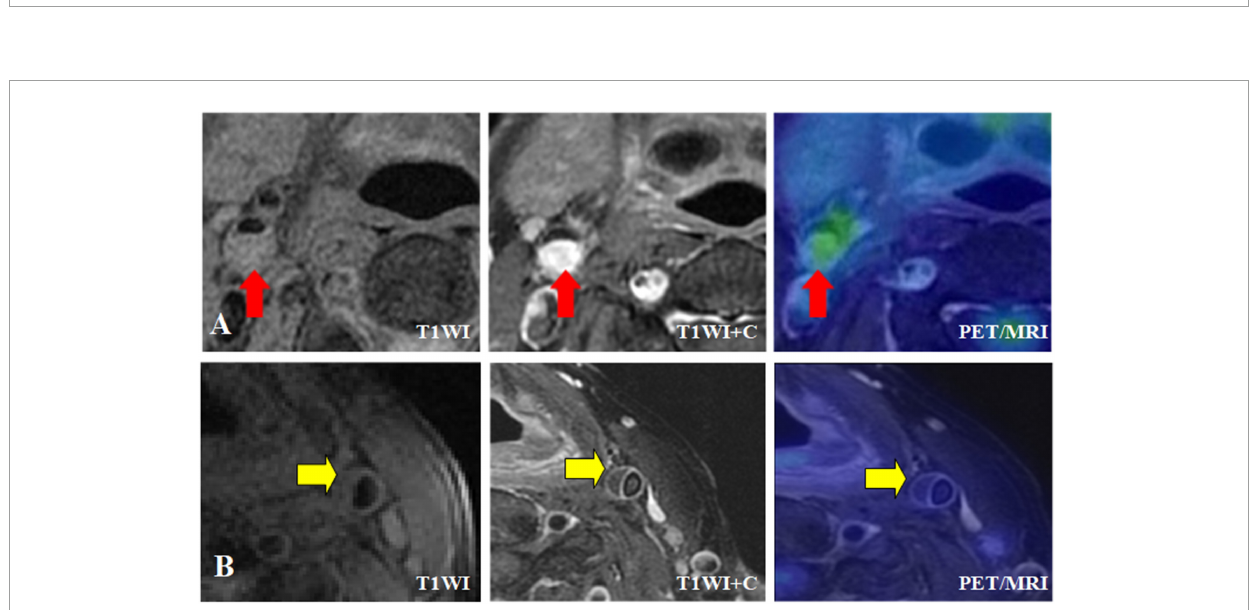
FIGURE5 Different MRI types of carotid plaque integrated 18 F-FDG PET/MR images. (A) Symptomatic patient with severe stenosis of right internal carotid artery lumen with plaque formation on T1WI, and the plaque was isointense. T1WI enhancement showed significant enhancement of right internal carotid artery plaque, and transverse fusion PET/MR showed high uptake of 18 F-FDG, SUVmax = 3.5, TBR = 2.5. (B) Asymptomatic patient with moderate stenosis of left internal carotid artery with plaque formation, plaque showed equal signal, HR-MRI transverse axial T1WI showed obvious continuous band enhancement of left internal carotid artery plaque surface, no enhancement in plaque, transverse fusion PET/MR showed no uptake of plaque 18 F-FDG, SUVmax = 2.05, TBR =